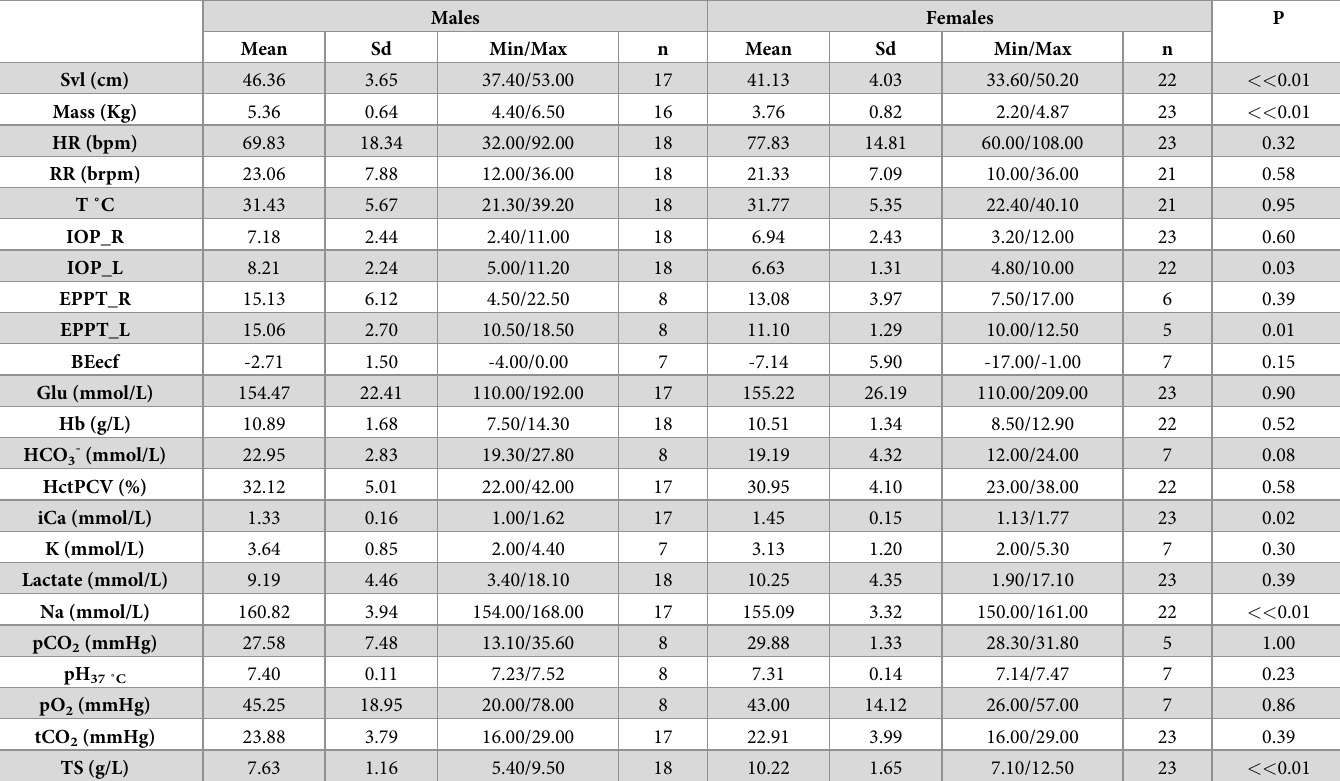
Table 1. Conolophus marthae intra-specific